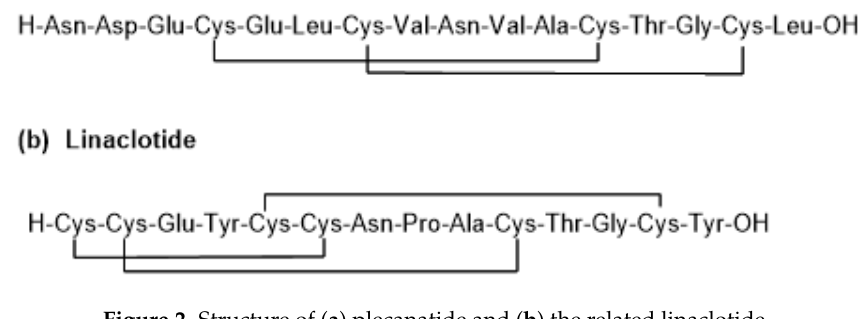
Figure 3. Structure of etelcalcetide. Amino acids of D configuration are shown in red. Etelcalcetide was developed by KAI Pharmaceuticals Inc. (South of San Francisco, CA, USA), a wholly subsidiary of Amgen Inc. (Thousand Oaks, CA, USA) and approved by the FDA on 7 February 2017 [14]. It is used for the treatment of secondary hyperparathyroidism (SHPT) in chronic kidney disease (CKD) in adult patients on hemodialysis [11,12,15–18]. Cardiovascular calcination is common in CKD patients, and it occurs as a result of impaired mineral homeostasis and secondary hyperparathyroidism [16]. As a calcimimetic agent, etelcalcetide binds to the calcium ‐ sensing receptor (CaSR) through a disulphide bridge between the D ‐ Cys of the etelcalcetide molecule and L ‐ Cys of the CaSRs, thereby enhancing activation of the receptor by means of extracellular calcium. Accordingly, activation of CaSRs on parathyroid chief cells decreases the secretion of parathyroid